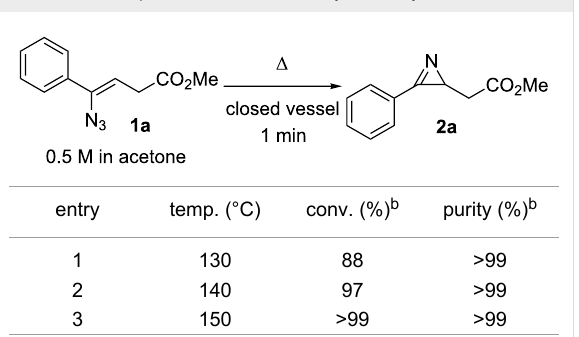
Table 1: Batch optimization of the thermolysis of vinyl azide 1a.